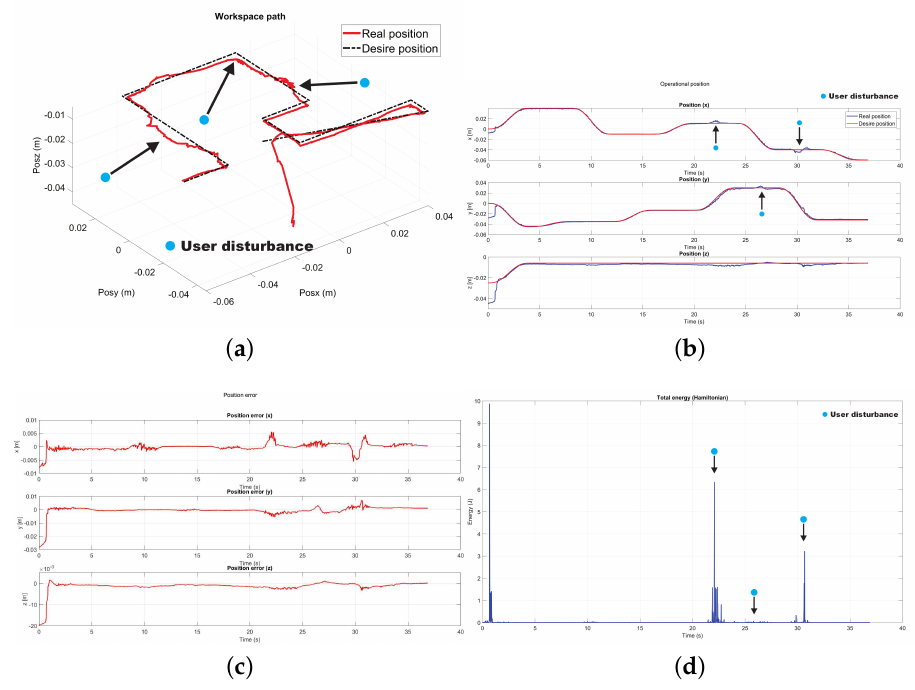
Figure 24. Experimental results with user in the loop: ( a ) Workspace path, ( b ) Operational position, ( c ) Position error, ( d ) Total energy in the